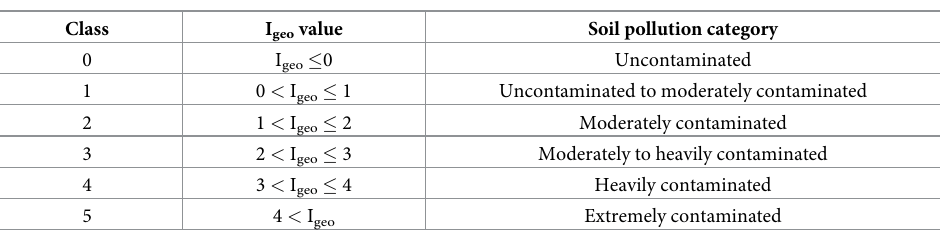
Table 5. Potential ecological risk index criteria and toxicity response coefficient of heavy metals. Ecological risk level RI Ecological risk level E i r